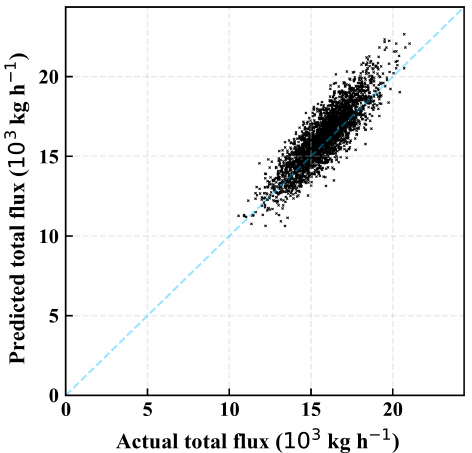
Figure 15. Relationship between the IME and flux rate under differ- ent sensible and latent heat fluxes of 200 and 400Wm − 2 (blue), and 220 and 220Wm − 2 (orange), compared to the original simulation sensible and latent heat fluxes of 400 and 40Wm − 2 (green). All cases are under the wind speed of 4ms − 1 . The detection threshold was 500ppmm − 1